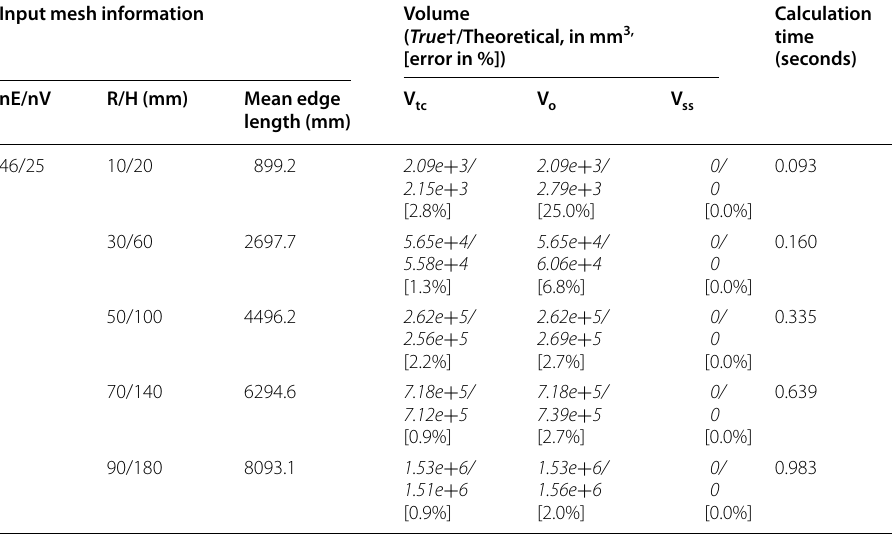
Table 3 Volume error estimation for “Cone”